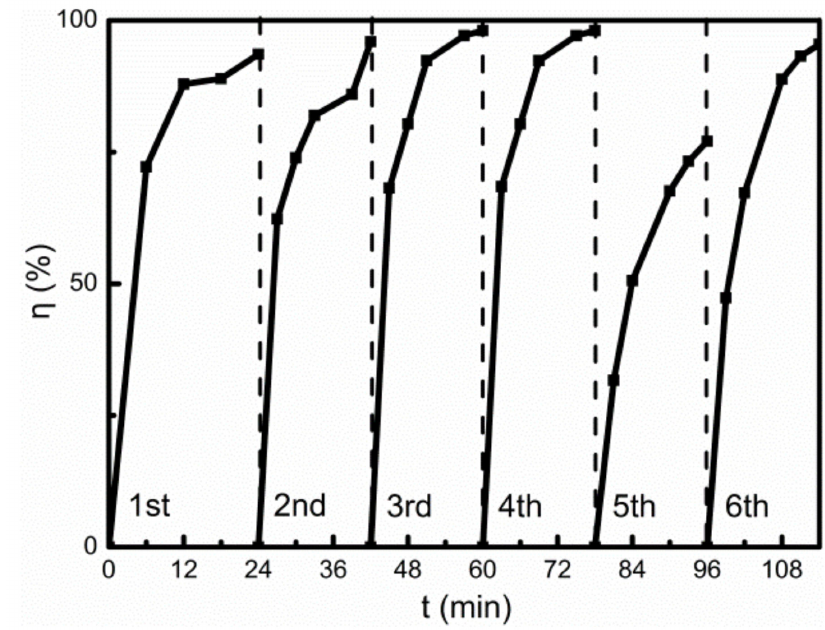
Figure 7. The rate of AR73 degradation by Fe 3 O 4 @TiO 2 for six